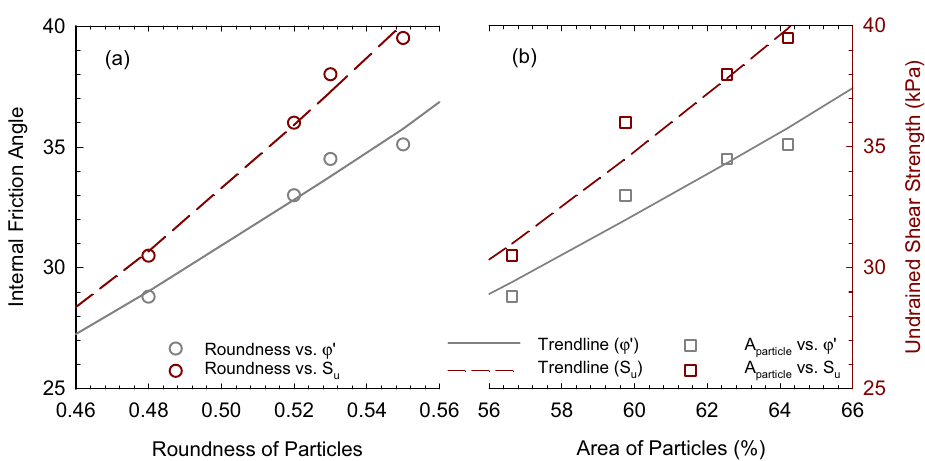
Figure 15. Internal friction angle and undrained shear strength versus particle index ( a ) roundness of particles, and ( b ) area of